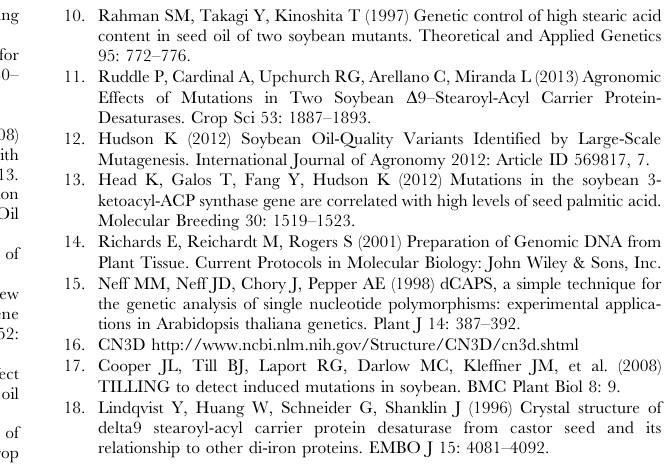
Table S2 M 3/ M 4 phenotypes and genotypes.